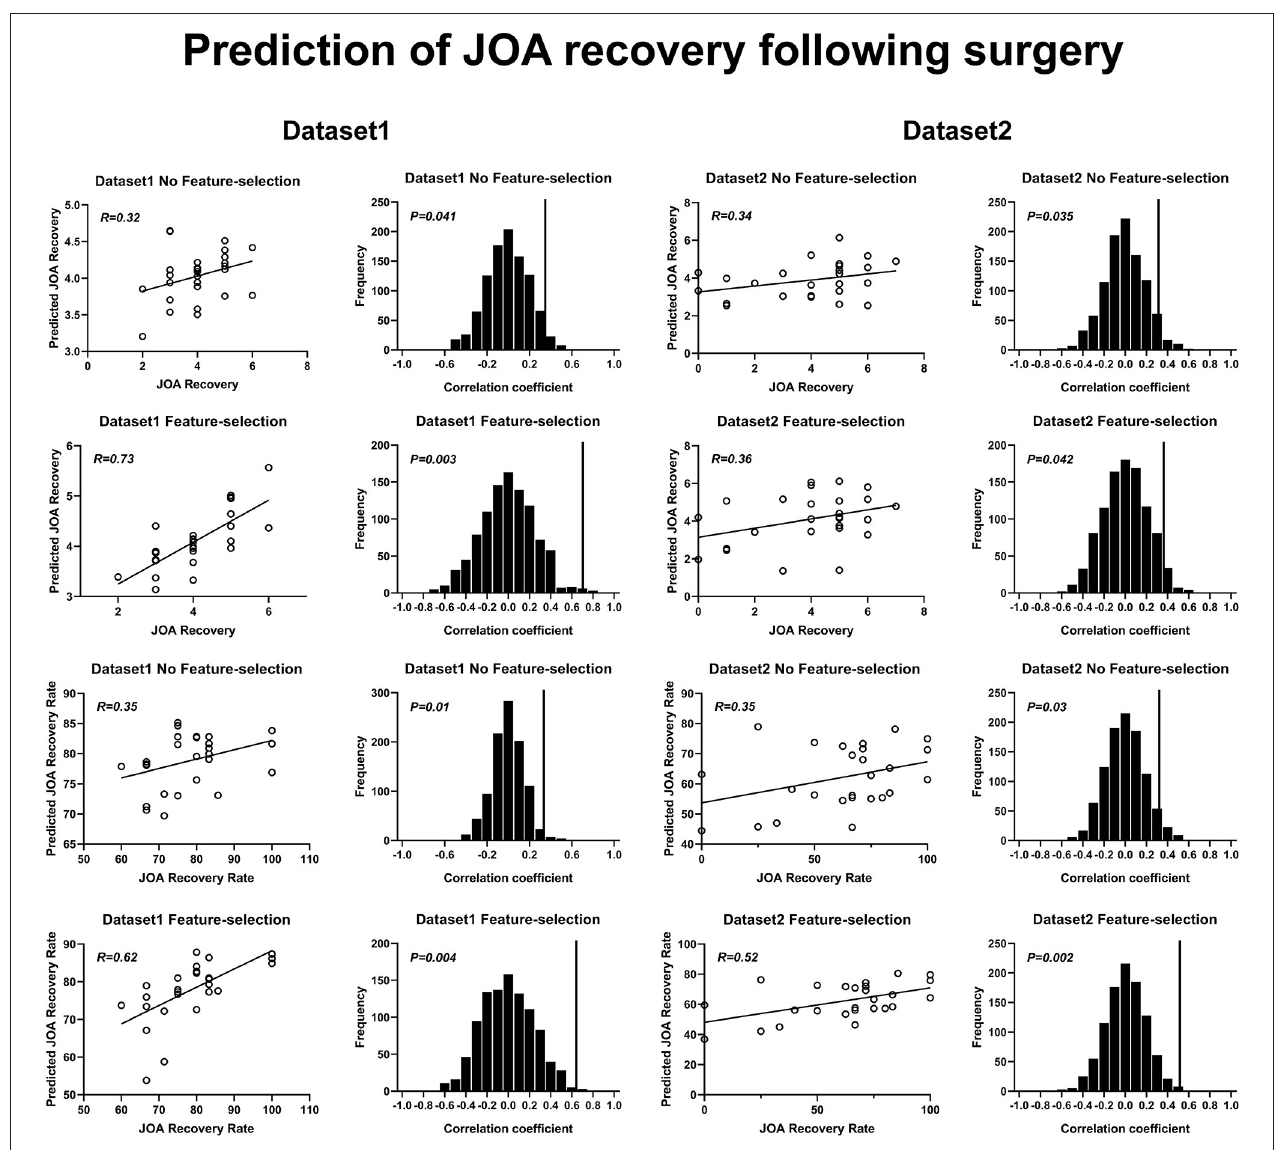
FIGURE 5 | Prediction of JOA recovery using rs-FC. Prediction of preoperative JOA scores. JOA, Japanese Orthopedic Association; rs-FC, resting-state functional connectivity. JOA recovery = postoperative JOA scores minus preoperative JOA